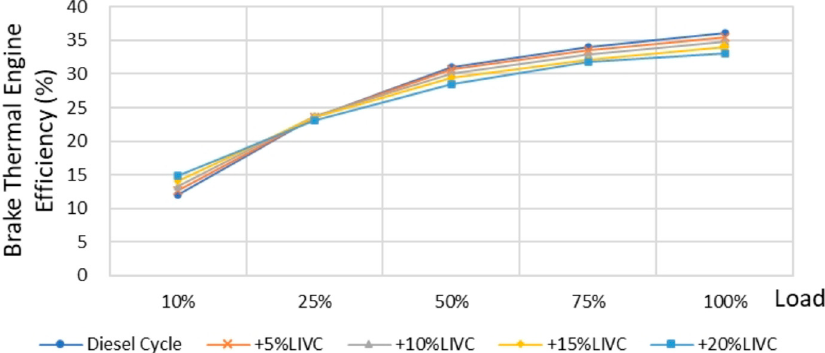
Figure 7. Comparison of BP under diesel engine LIVC Miller cycle.